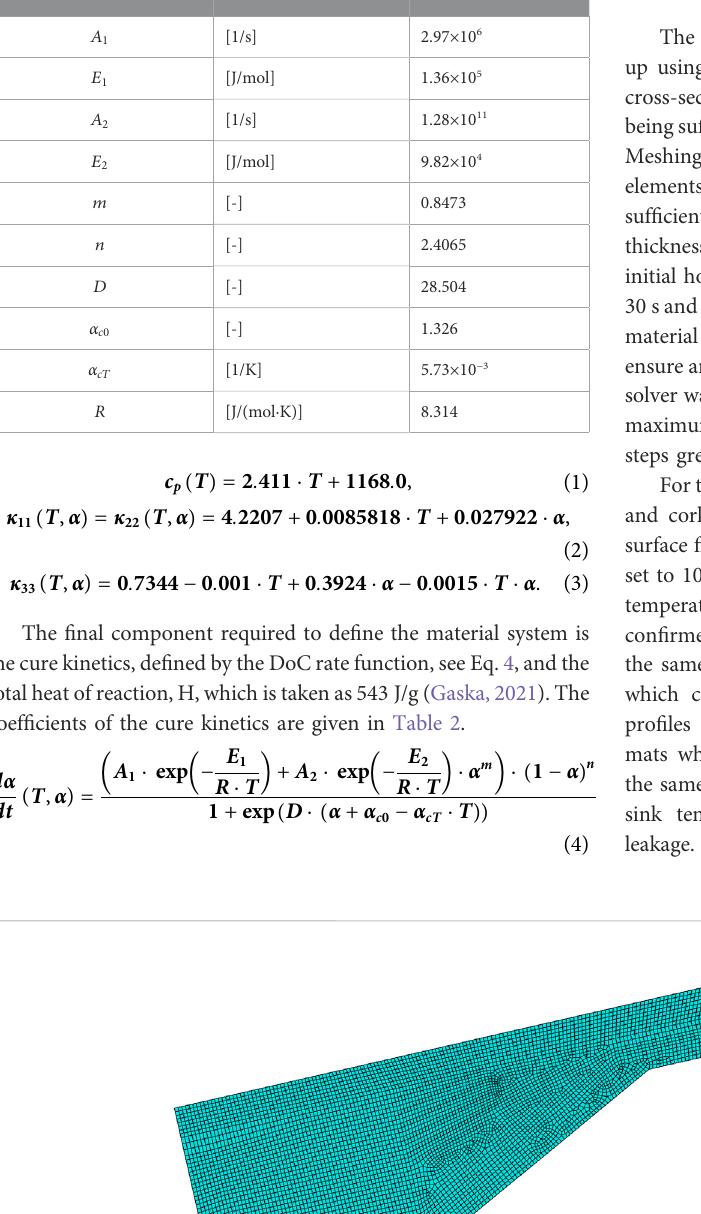
TABLE 2 Cure kinetic parameters for MTC 400 resin system (Gaska, 2021). Parameter